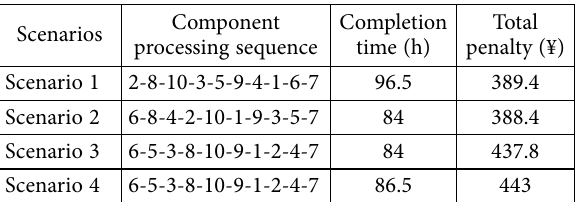
Table 3. Optimization results under four transportation